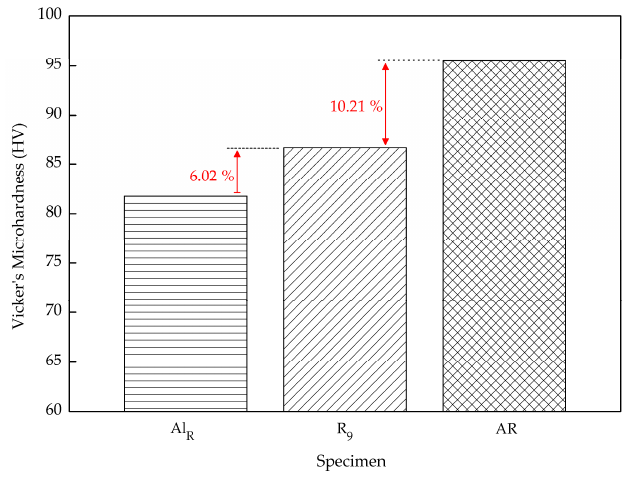
Figure 5. Residuals for Vickers microhardness between maximum (R 9 ) parameter settings compared to the Al R and AR AA6061 samples.